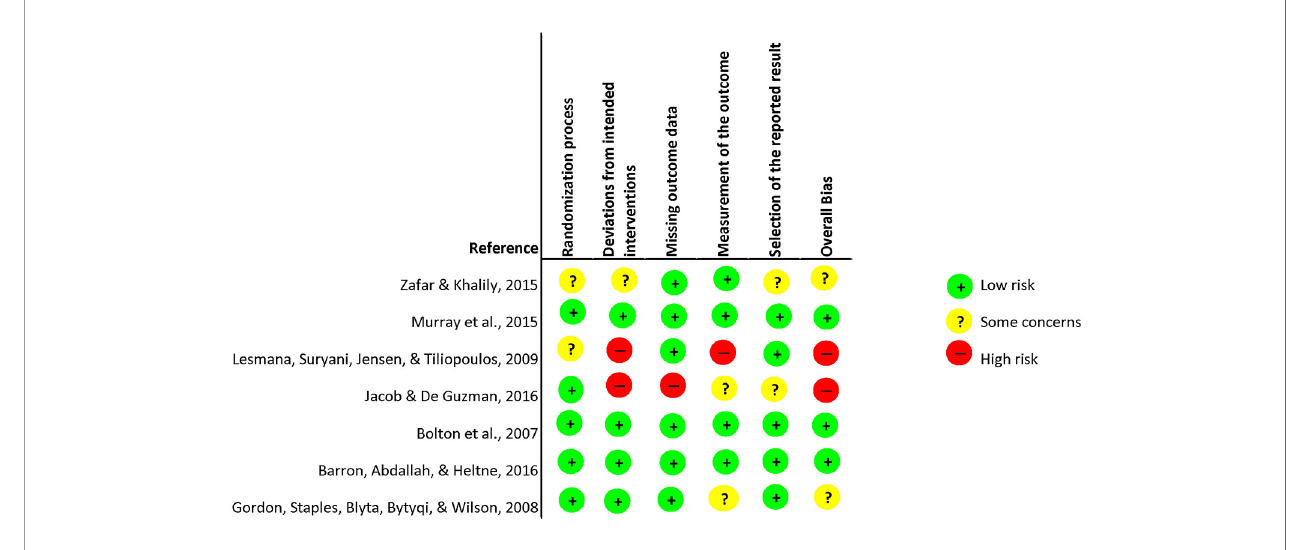
FIGURE 2 | Risk of Bias Cluster Randomized Controlled Trials.